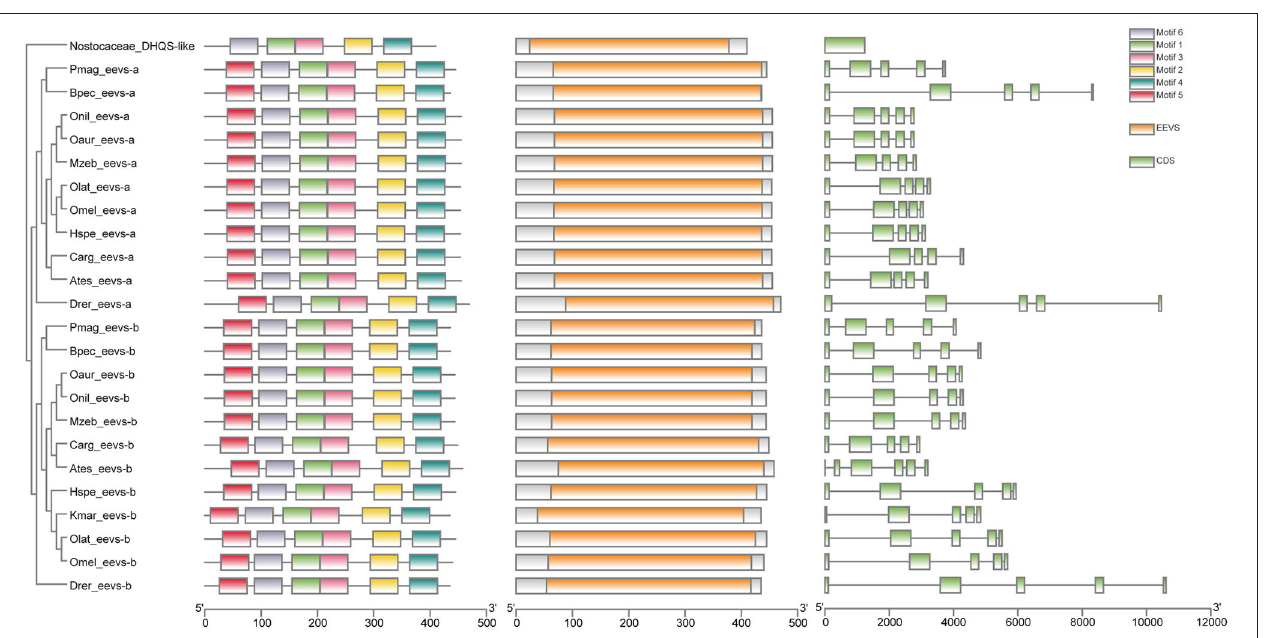
FIGURE 4 | The rooted NJ tree of teleost eevs -like genes. It was constructed with cyanobacteria DHQS-like as the outgroup. The first column is the rooted tree, the second column is the six motifs derived from MEME web service, the third column is the conserved domain CDD derived from NCBI, and the four column is the detailed structures of eevs -like